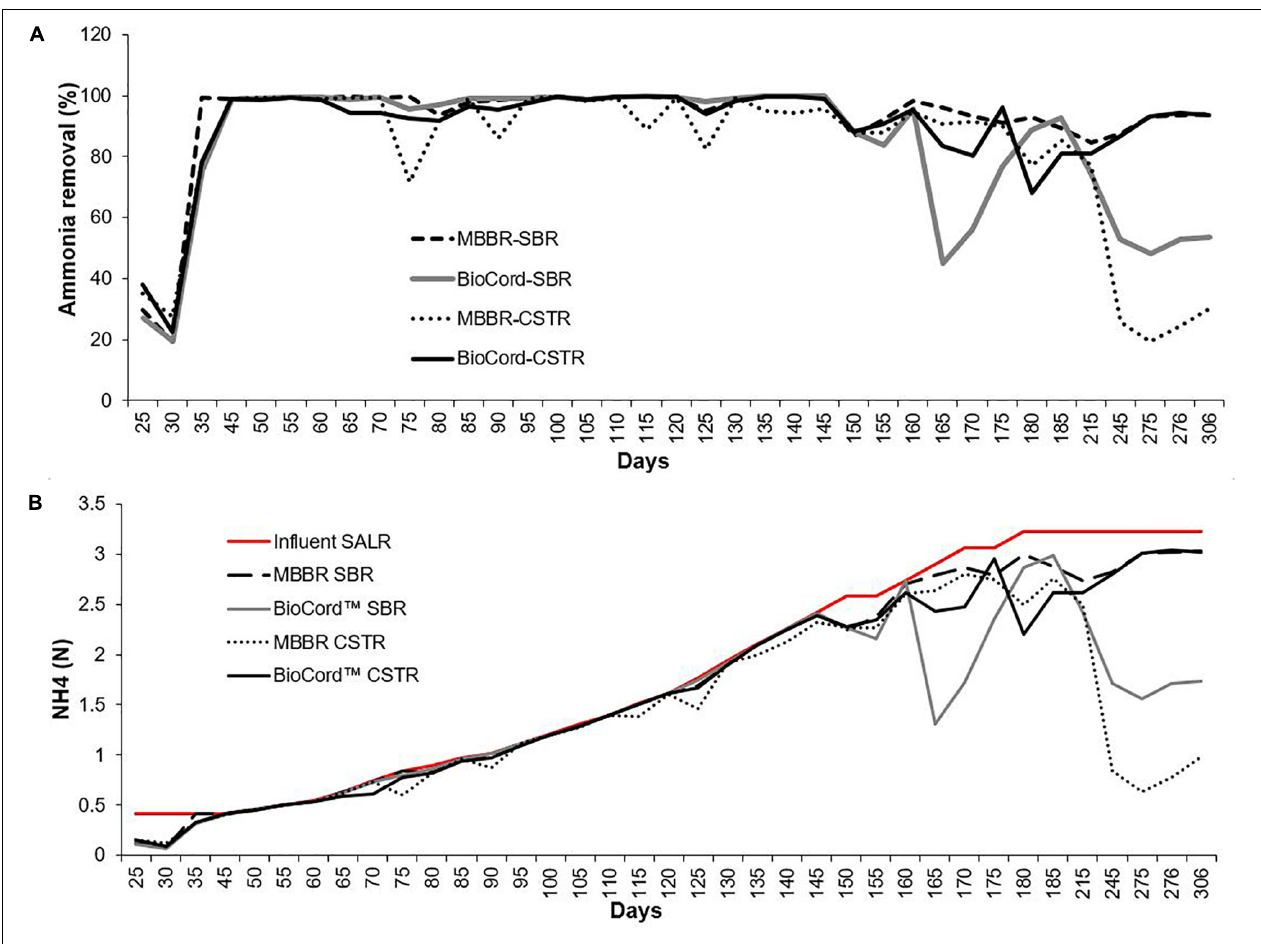
FIGURE 2 | (A) The ammonia removal efficiency in the hybrid and fixed-film bioreactors. (B) The ammonia removal rate [NH 4 (N) g/m 2 .day] in all bioreactors with the influent surface area loading rate